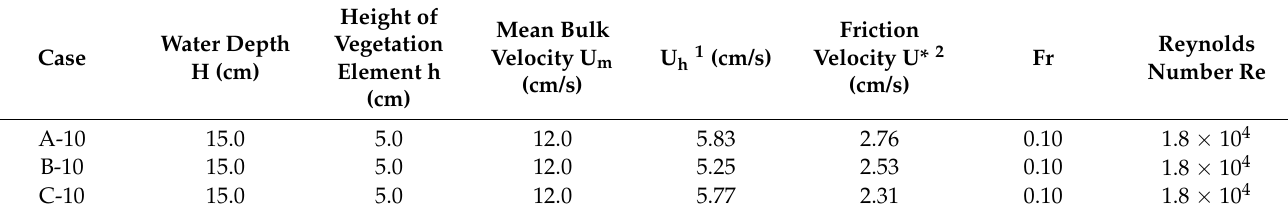
Table 1. Main flow features of the experiments in Nezu et al.